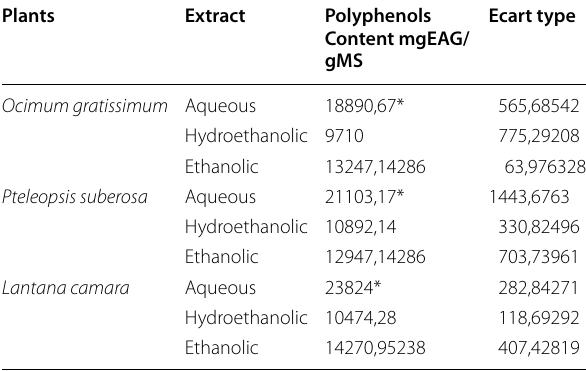
Table 4 Total polyphenol content of the plant extracts studied Plants